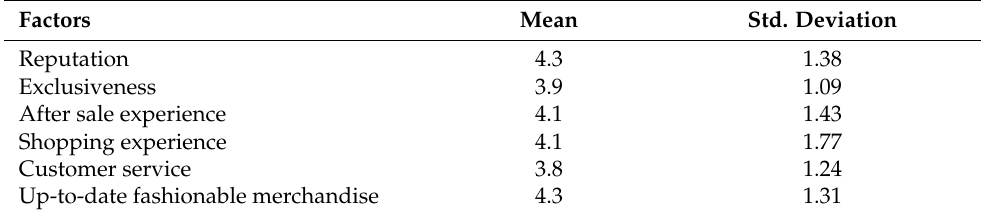
Table A2. Store factors influence on purchasing luxury brands.